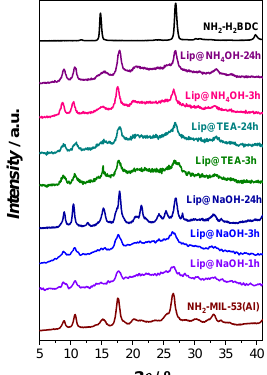
Figure 1. Normalized PXRD patterns of free-enzyme NH 2 -MIL-53(Al) (wine line, at the bottom), of the protonated linker NH 2 -H 2 BDC (black, at the top) and the in situ biocatalysts Lip@NH 2 -MIL-53(Al)-DA-x prepared with different deprotonating agents DA (NaOH, TEA, or NH4OH) and after different synthesis times x (from 1 to 24 h).